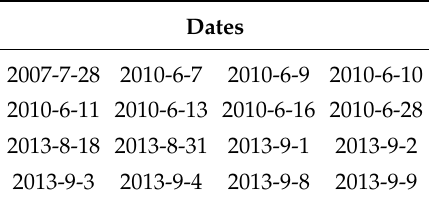
Figure 8. Common areas simultaneously identified by all methods of Section 3 for the data of all three stations and all years in the range of 2001–2016. Colours for each station are: blue for Agia Paraskevi, red for Lykovrissi, and magenta for Maroussi. Vertical axis has no units and discriminates the common areas of the three stations. Table 1. Coincidence dates of common segments of Figure